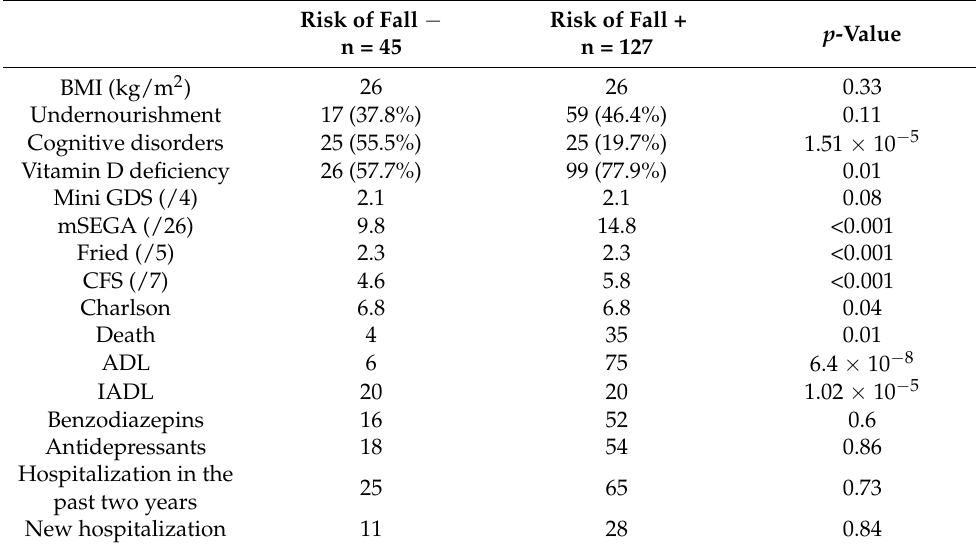
Table 3. Comparison of certain variables of interest according to the risk of